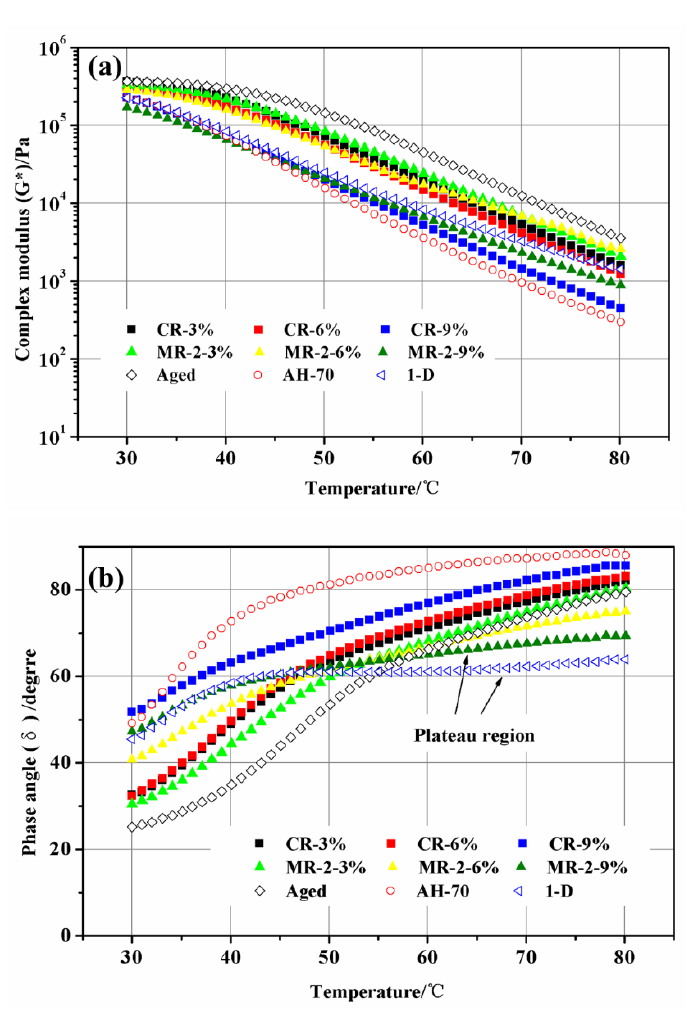
Figure 9. DSR analysis results for CR and MR-2 rejuvenated binders at different contents: ( a ) curves of complex modulus as a function of temperature; ( b ) curves of phase angle as a function of temperature.